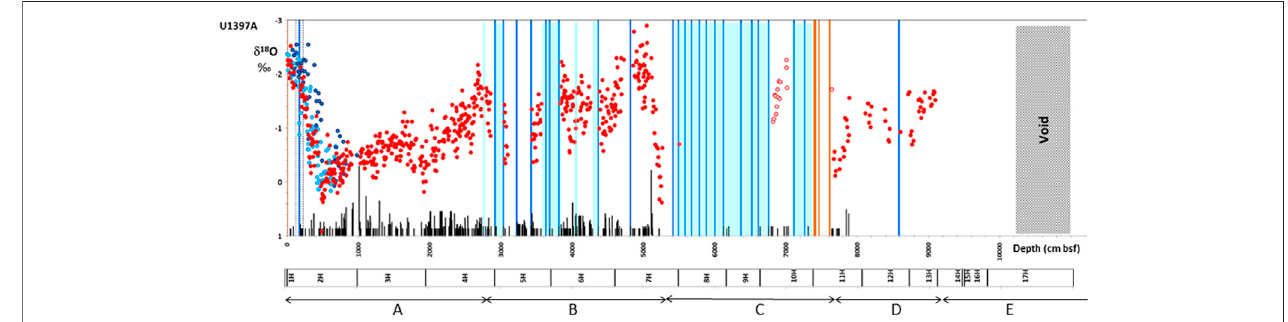
FIGURE 4 | Synthetic logs and δ 18 O values of core U1397A. Comparison with cores U1401A and CARMAR-4. δ 18 O data: red dots U1397A; light blue dots: CARMAR-4 (Boudon et al., 2013); dark blue dots: U1401A (Solaro et al., 2020). Blue domains: turbiditic zones; blue bars: turbidites > 50 cm; black bars: tephra units; orange bars: debrites. The height of the bars relates to the relative thicknesses of the deposits. Gray domains: void in core; dots: δ 18 O values; open circles: series of samplesofwhichthe δ 18 Opatternisnotconsistentwiththestratigraphicpositioninthecore.Theycorrespondtosedimentaryunitsdisplacedbysubmarinesliding ( “ duplicate units ” ). Letters are the different core section labels and lithological units (see Figure 3A